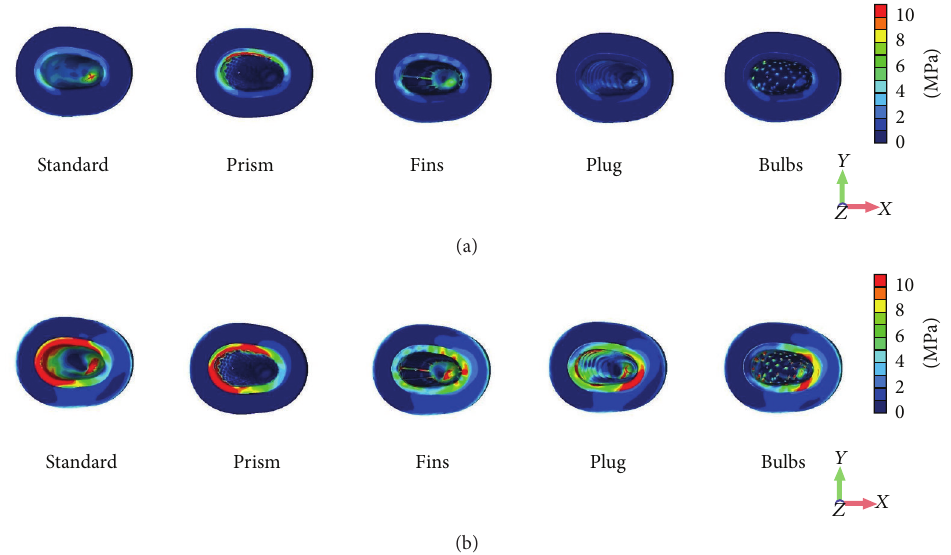
Figure 6: Distribution patterns of the tensile principal stress under vertical (a) and oblique (b) loading components.